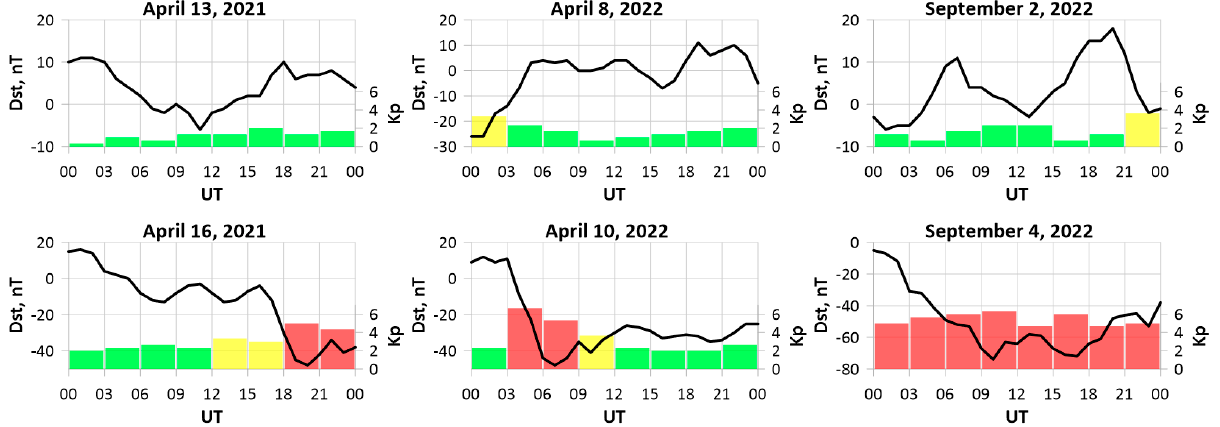
Figure 2. Kp (colored bars) and Dst (black curves) during the chosen storms (upper panels) and the quiet reference days (lower panels).